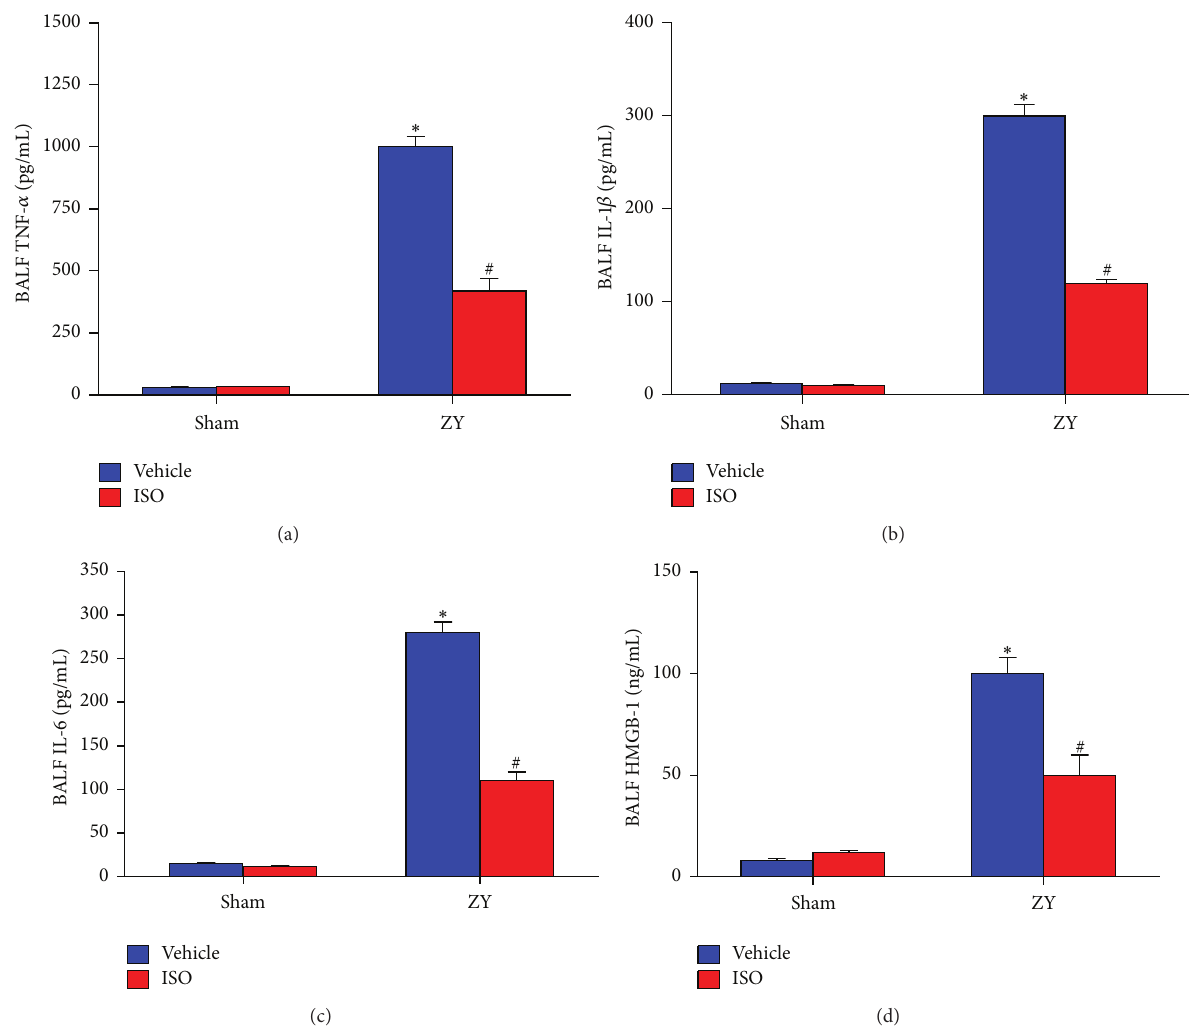
Figure 5: Effect of 0.7% ISO treatment on cytokine production in BALF in ZY-treated mice at 24 hrs. The following inflammatory indicators in BALF were measured by ELISA: (a) TNF- 𝛼 ; (b) IL-1 𝛽 ; (c) IL-6; and (d) HMGB-1. The animals were treated as shown in Figure 1(a). Data represent means ± SD ( 𝑛 = 10 mice per group). ∗ 𝑃 < 0.05 versus sham + vehicle; # 𝑃 < 0.05 versus ZY +